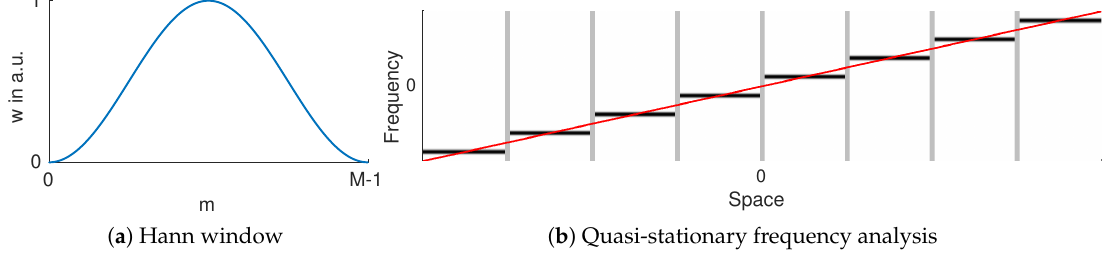
Figure 5. ( a ) Exemplary spatial short-term Fourier transform window. ( b ) Illustration of quasi-stationary frequency analysis of the signal (red). Within each spatial window (within gray verticals) frequencies are stationary. Here, the strongest response per window occurs at its average